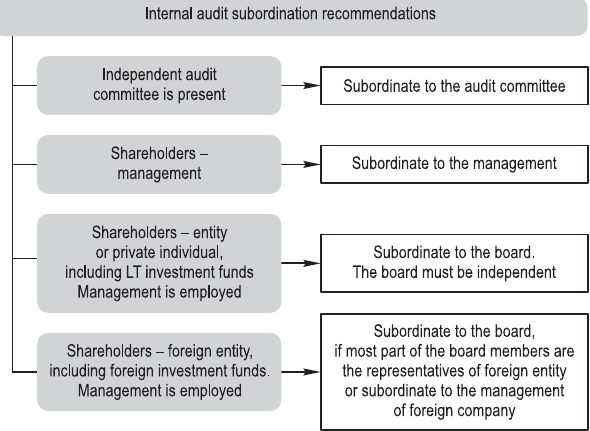
Fig. 4. Internal audit subordination